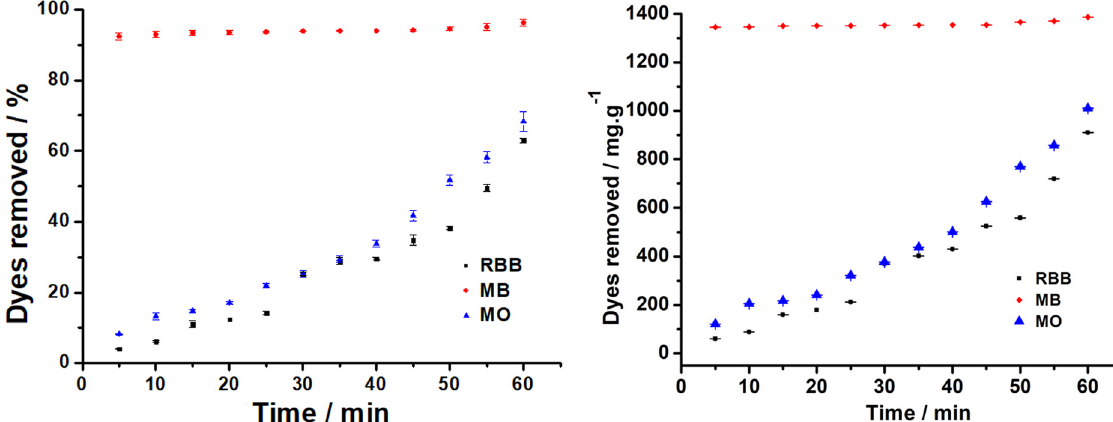
Figure 6: Degradation of dyes by ferrate with the e ff ect of contact